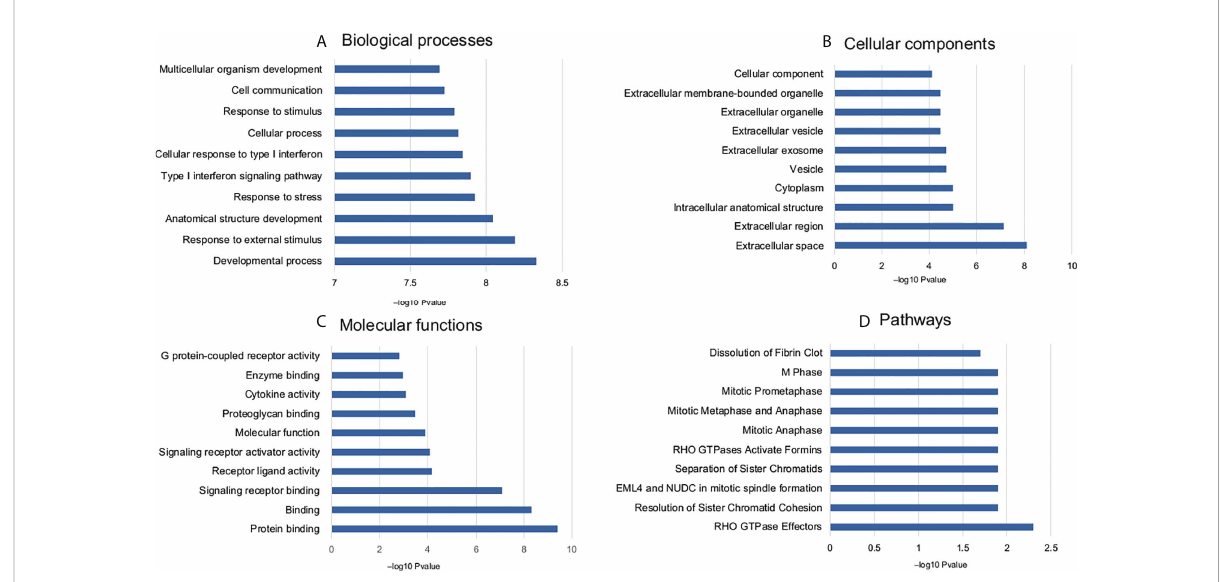
FIGURE 3 Enriched GO terms and pathways (top 10) common DEGs associated with doxorubicin response. (A) biological process, (B) cellular components, (C) molecular function, and (D)